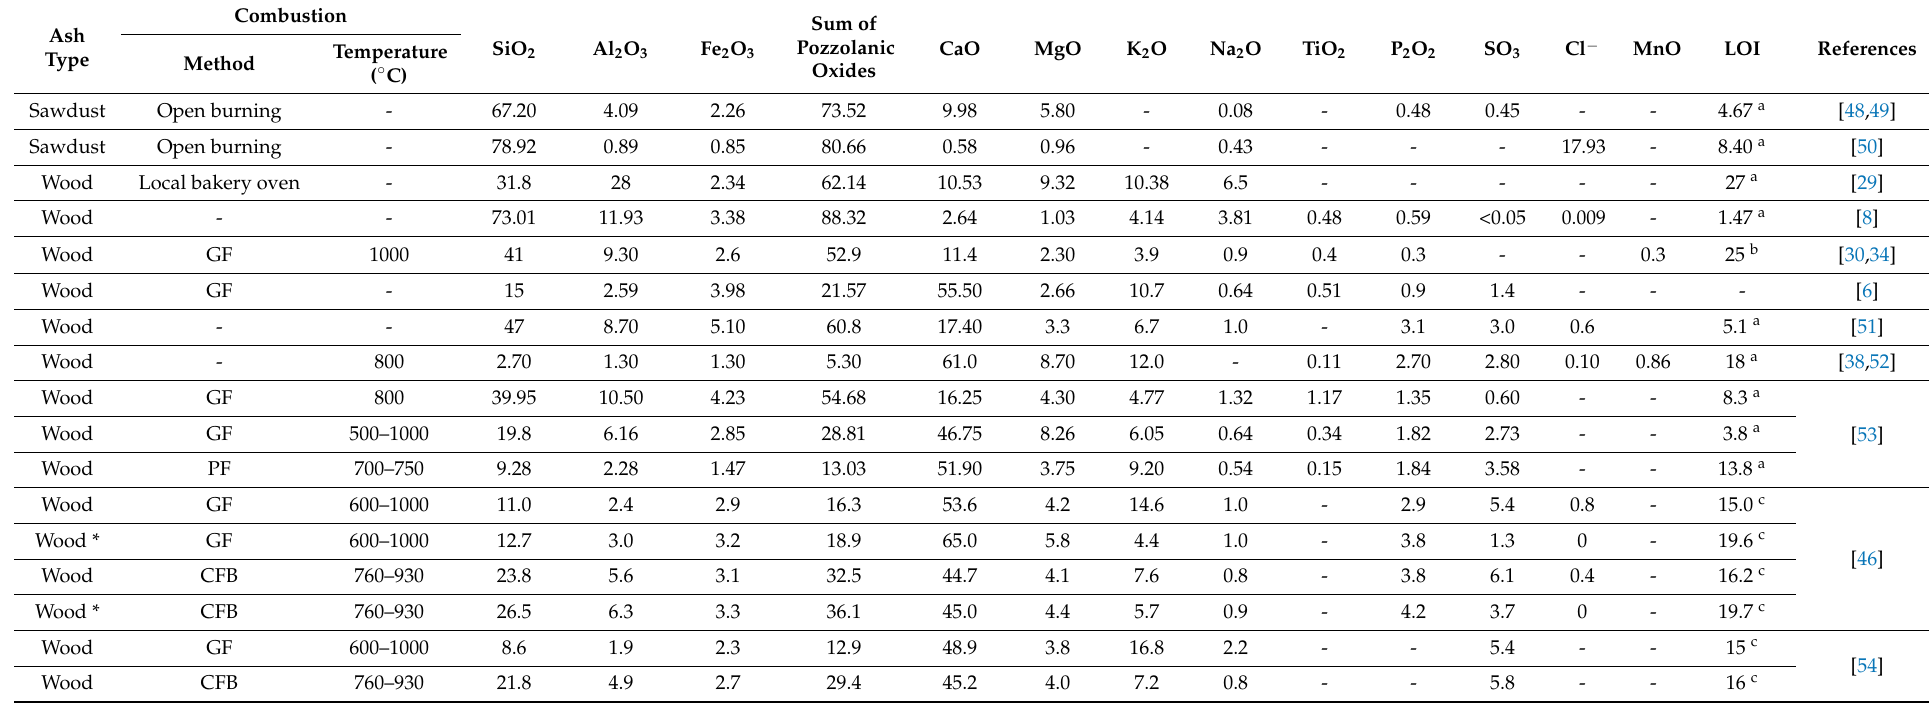
Table 1. Chemical composition and loss on ignition of different wood ashes